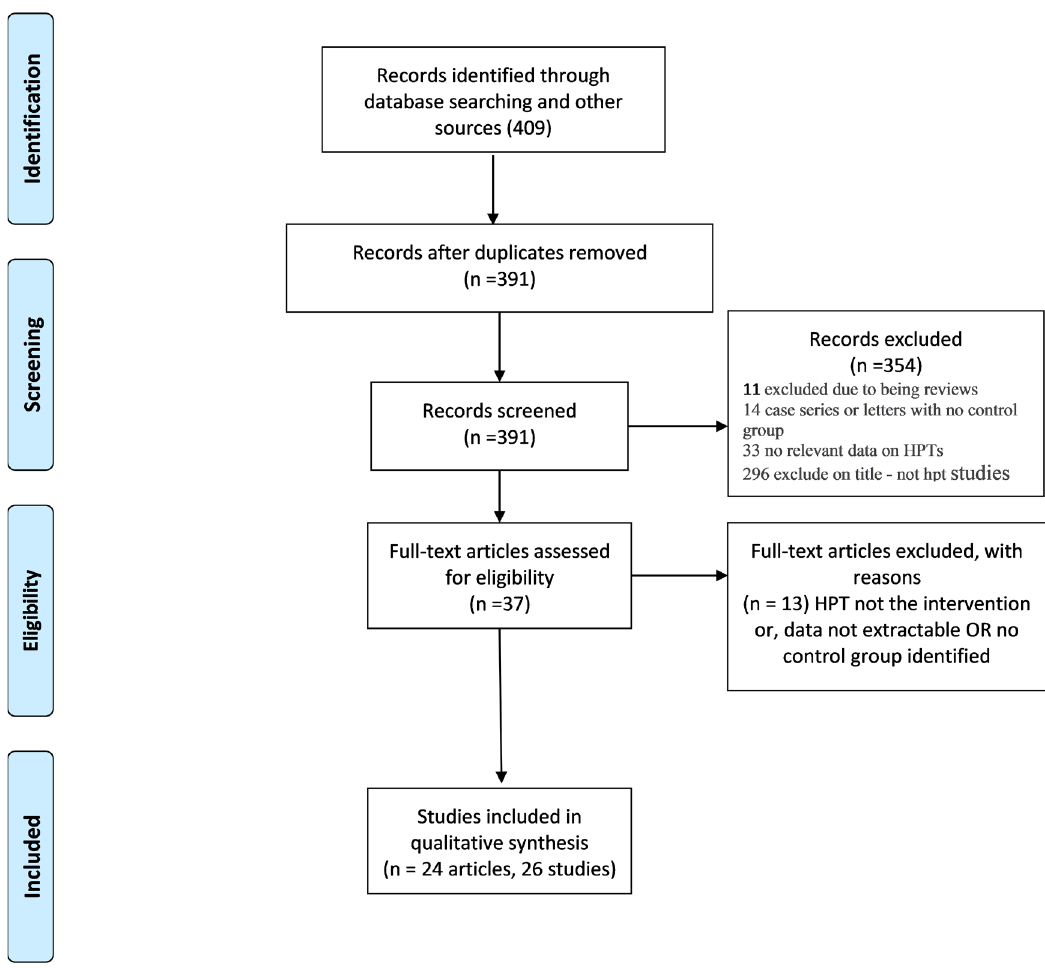
Figure 1. Study flow diagram showing inclusion of relevant